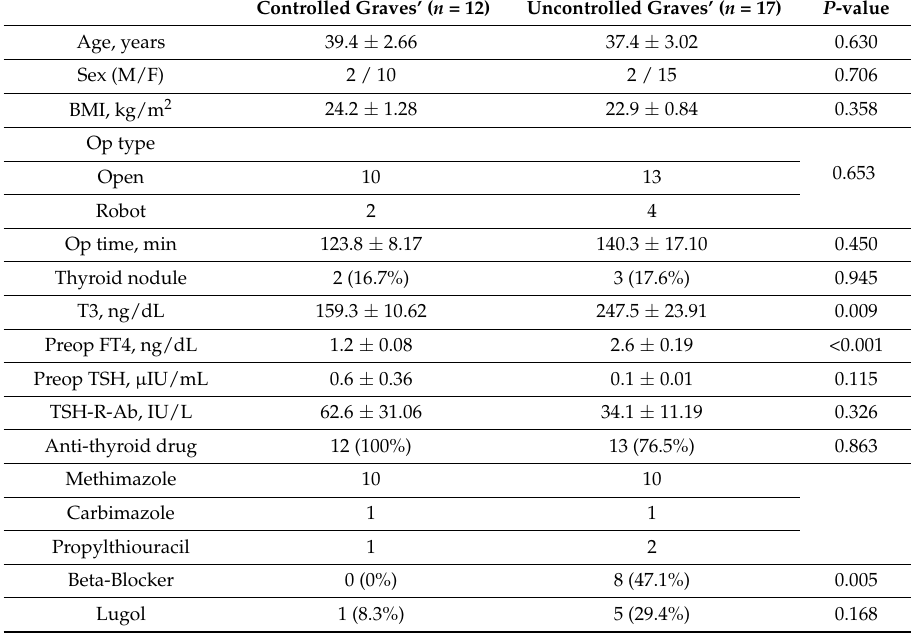
Table 1. Demographic and clinical characteristics of patients with controlled and uncontrolled Graves’